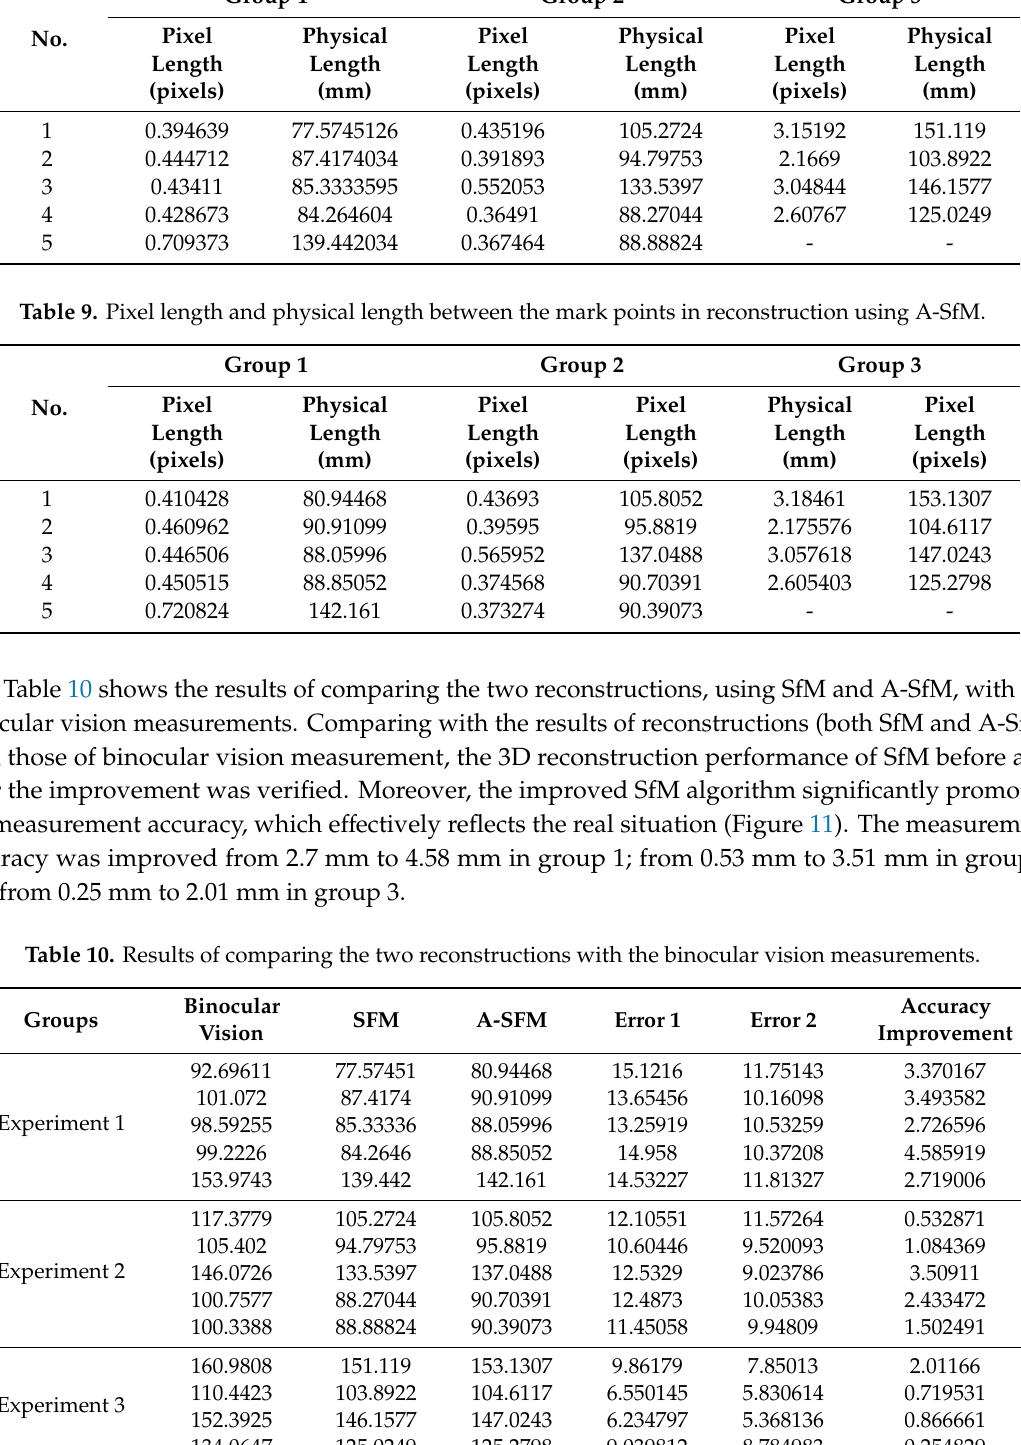
Table 8. Pixel length and physical length between the mark points in reconstruction using SfM.